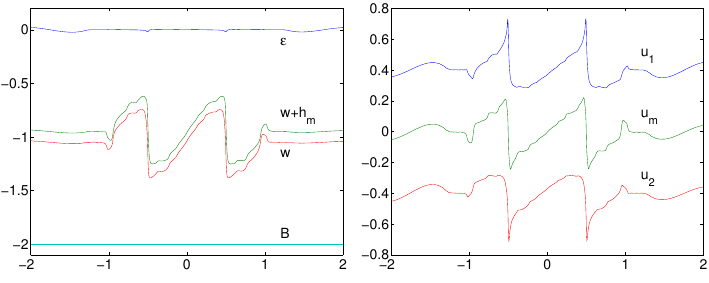
Figure 5. Example 1: Solution of the three-layer system with (cid:98) h m = 0 .